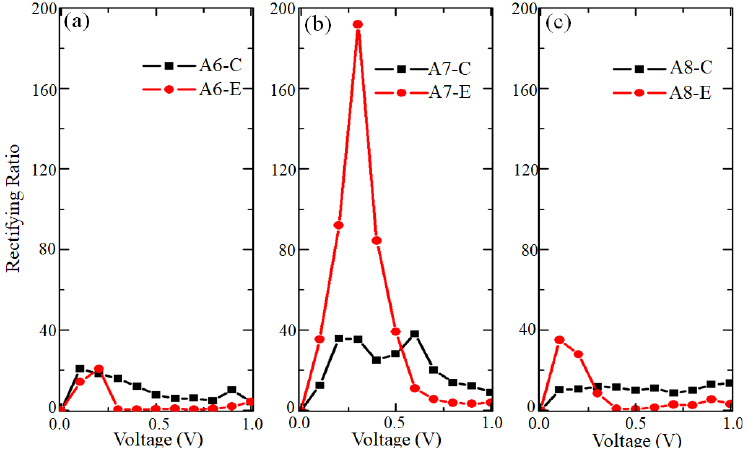
ASiNR devices with widths of 6, 7, and 8 (N = 6, 7, and ∠